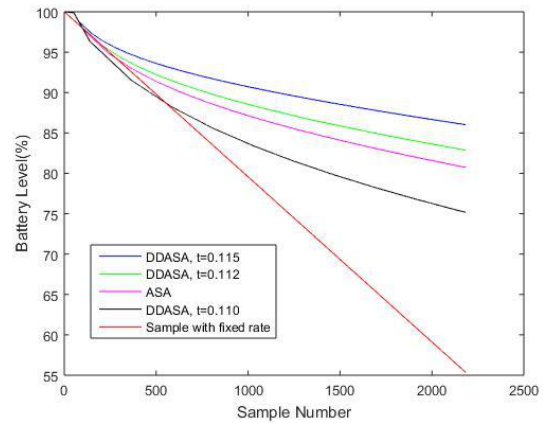
Figure 8. Algorithm performance with respect to the remaining battery level. Table 3. Performance comparison between ASA and data-driven adaptive sampling algorithm (DDASA) using DO data.